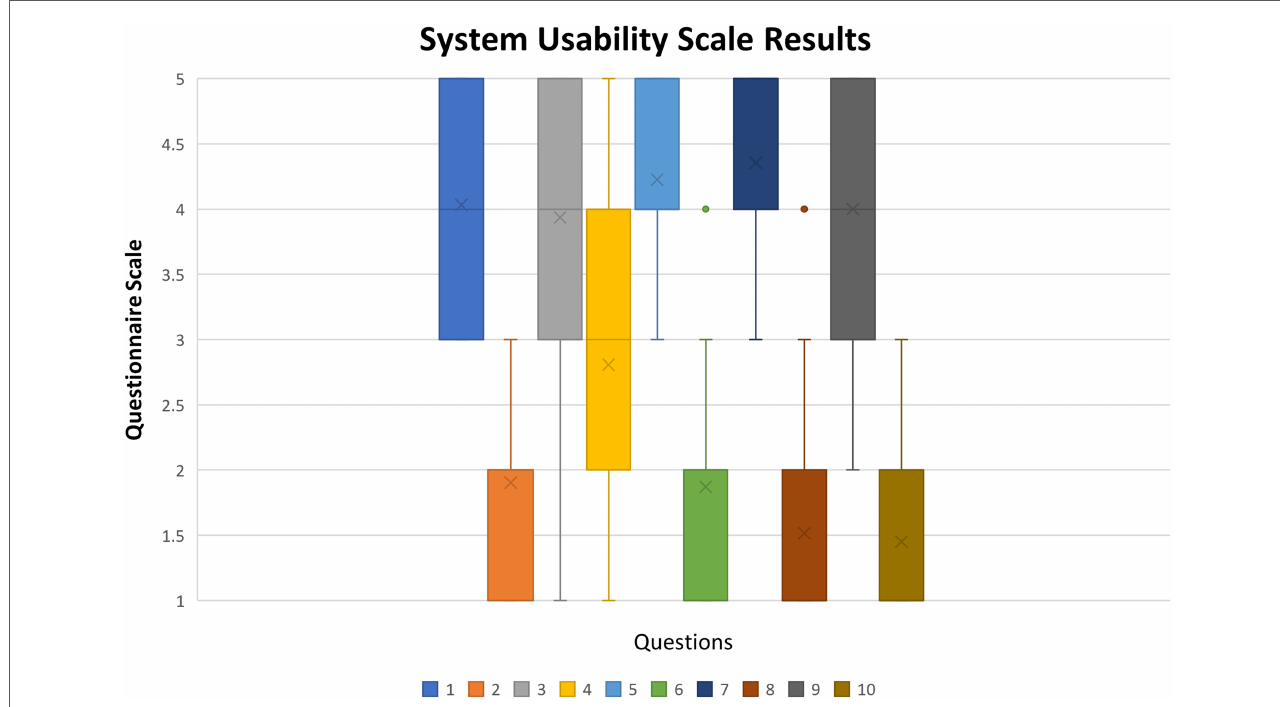
FIGURE 8 Boxplot chart of system usability scale results (x stands for mean value, rectangle upper and lower quartile with at least 50% of values, whiskers represent the 0th and fourth quartile when there are